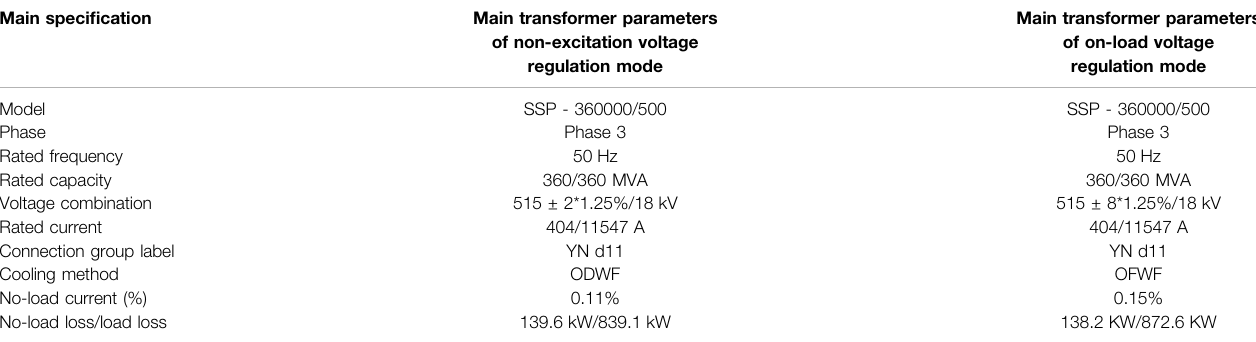
TABLE 1 | Parameter table of pumped storage main